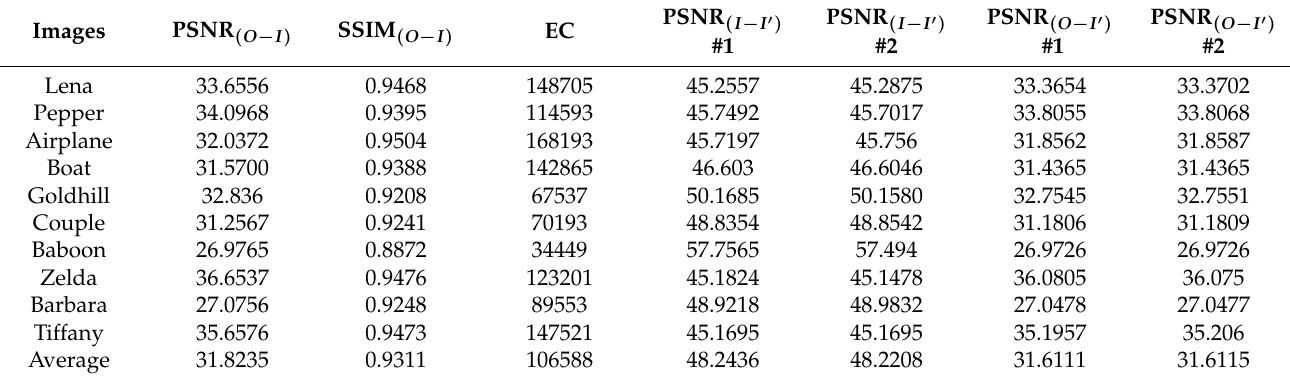
Table 1. Comparison of PSNR for all dual RDH AMBTC images (when threshold T =